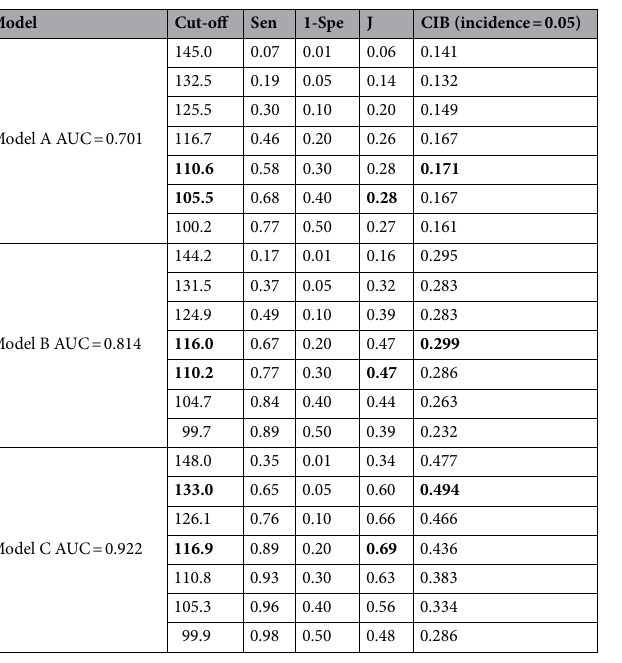
Table 3. ROC analysis of J and CIB (incidence = 0.05) to determine the optimum cut-off value in a simulated dataset. Boldface: Optimum cut-off